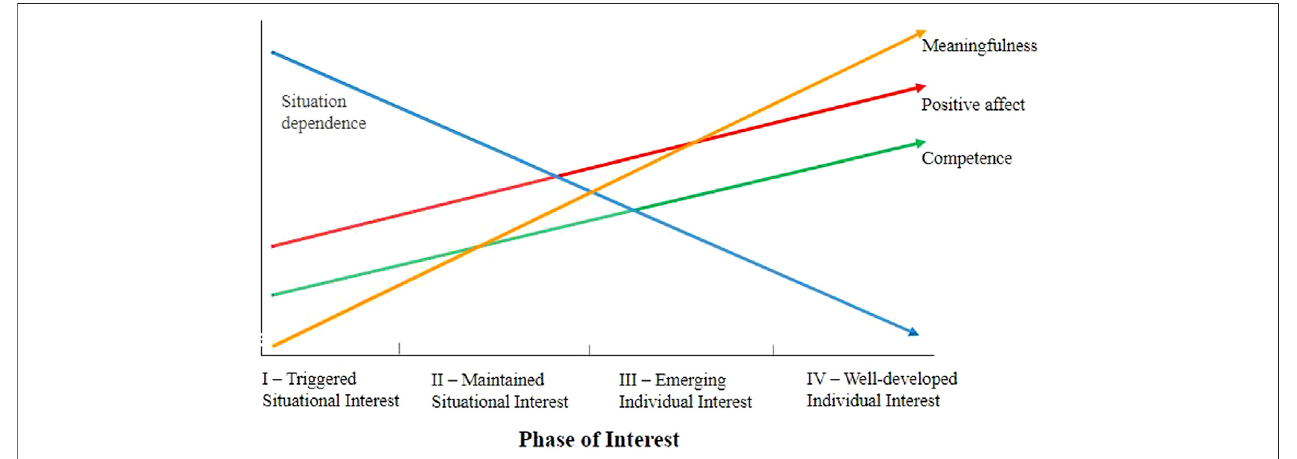
FIGURE 1 | Hypothesized relationships among key interest